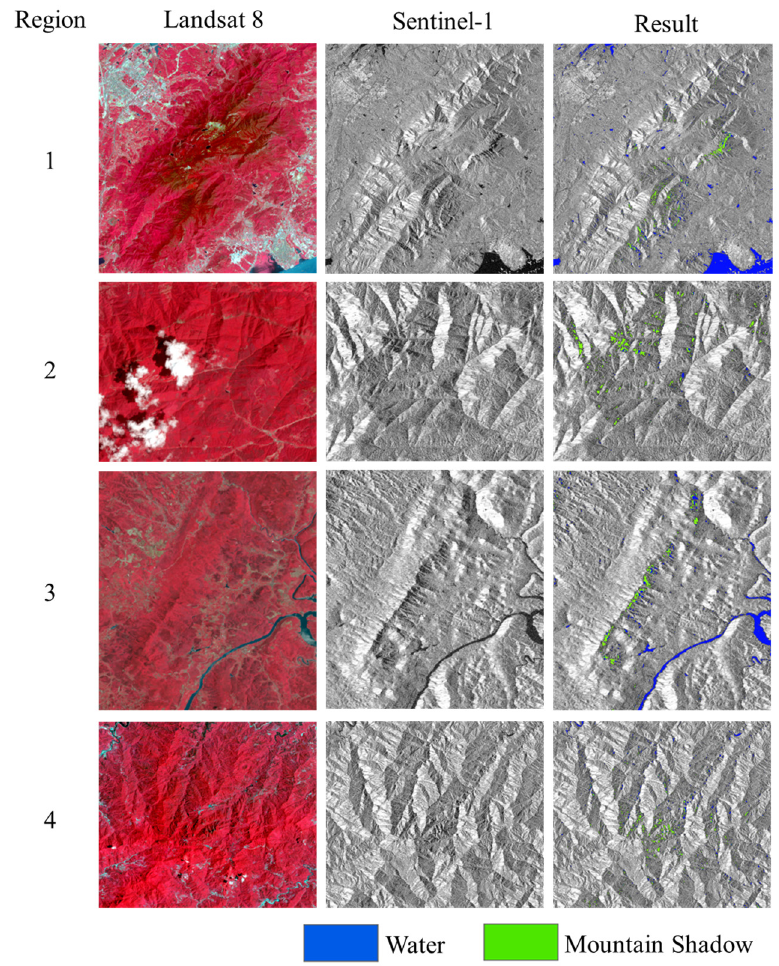
Figure 9. Detailed maps after removing the mountain shadows.